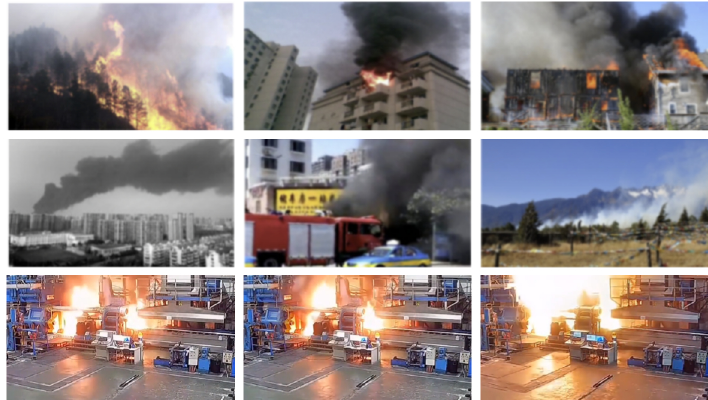
Figure 5. Example images. The dataset used Internet downloaded images and collected public datasets to detect smoke and fire.